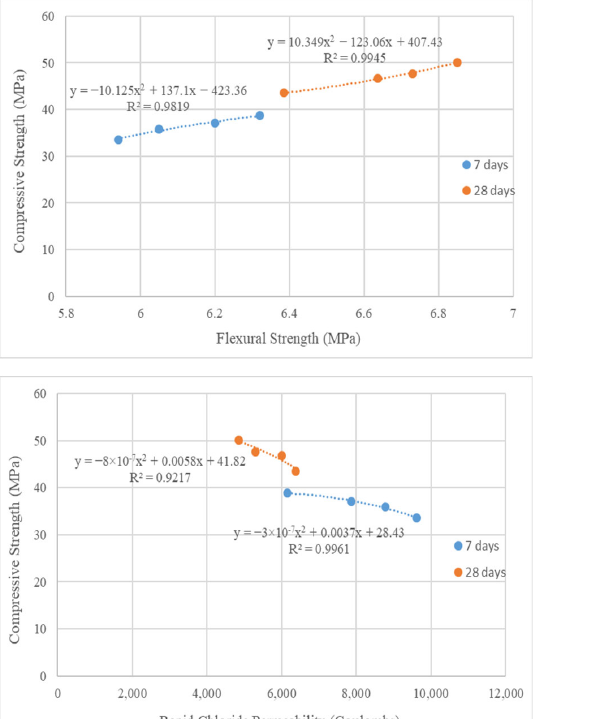
Figure 10. Correlation relations between durability properties.